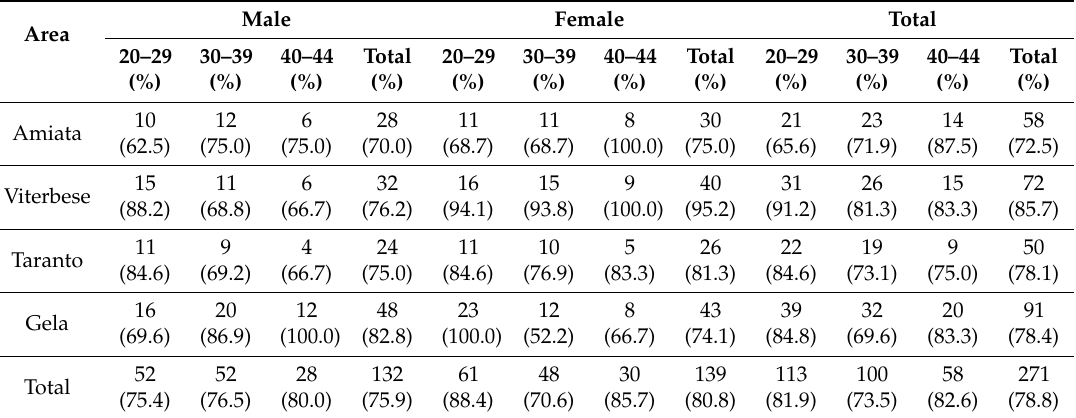
after the accession to the interview and the collection of a urine sample. The percentage was calculated on the contacted subjects by